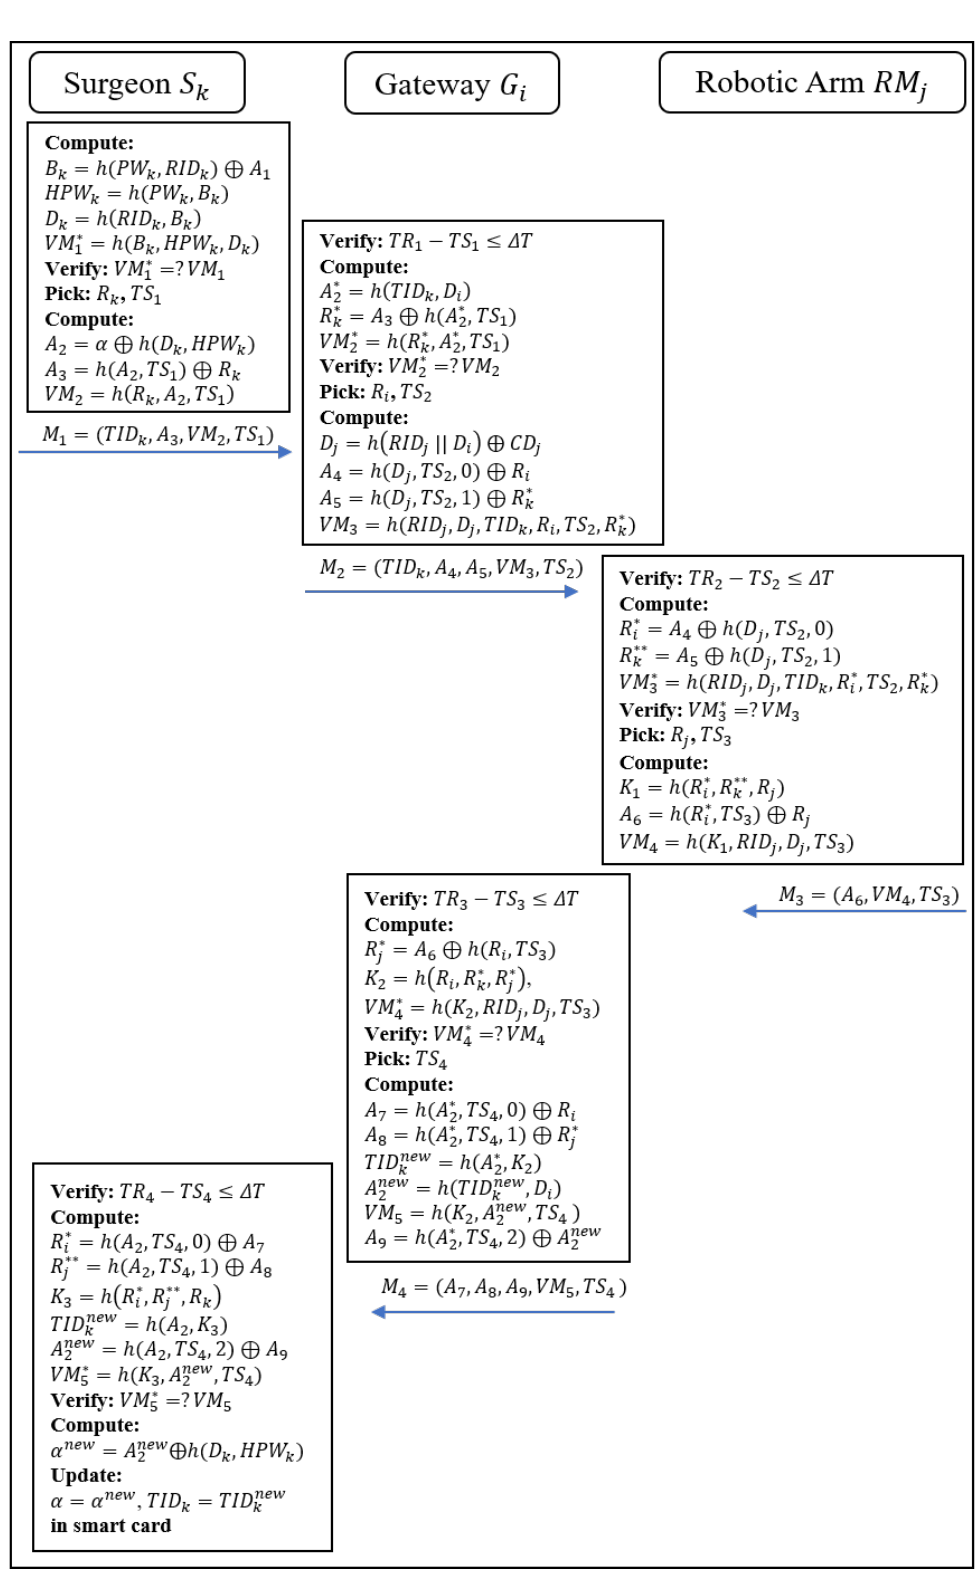
Figure 5. Login, authentication, and session key agreement phase of the enhanced scheme.